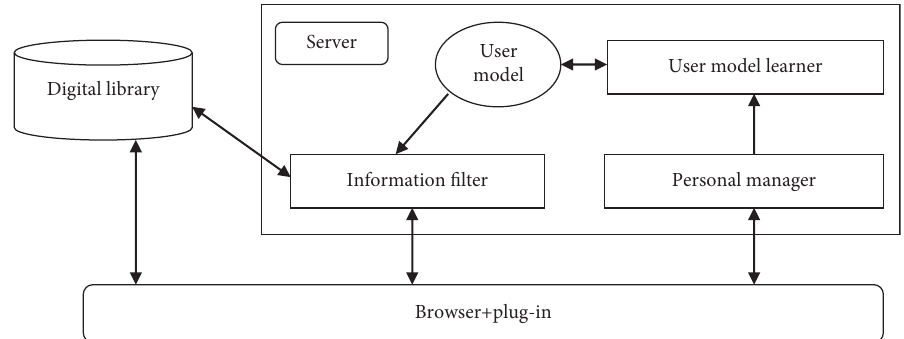
Figure 2: System architecture.